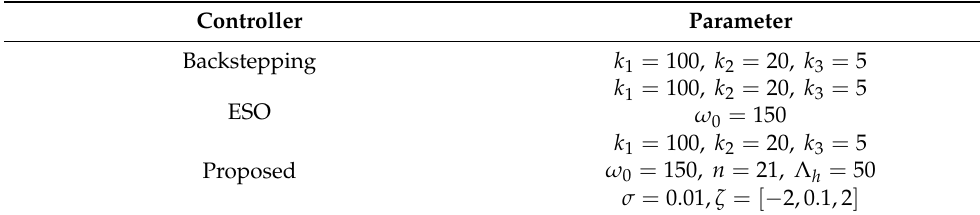
Table 2. Control